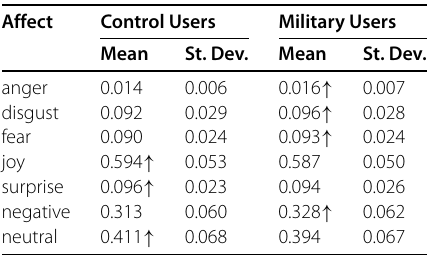
Table 5 Differences in emotion and sentiment proportions expressed by military and control users between 2011-2014 aggregated over 6 points of